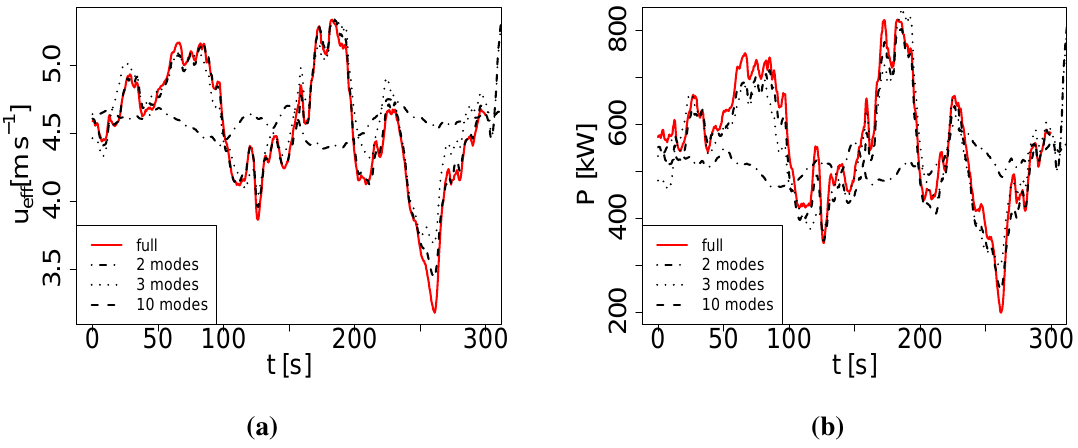
Figure 7. The measures ( a ) u POD